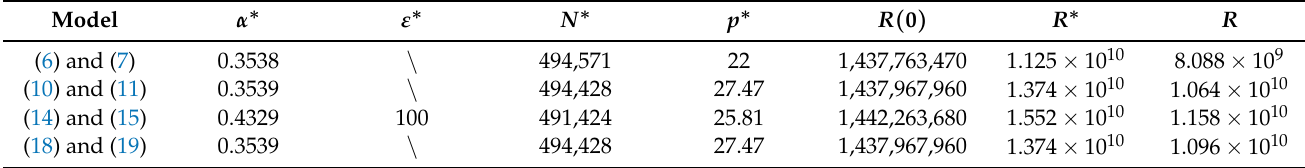
Table 3. Optimal breeding results based on the second group of parameter values. R ( 0 ) is the profit earned at the initial moment, Since N ( 0 ) > N ∗ , every optimal strategy is to sell the excess over N ∗ and the profit is R ( 0 ) . The meanings of R ∗ , R and ε = 100 are the same as in Table